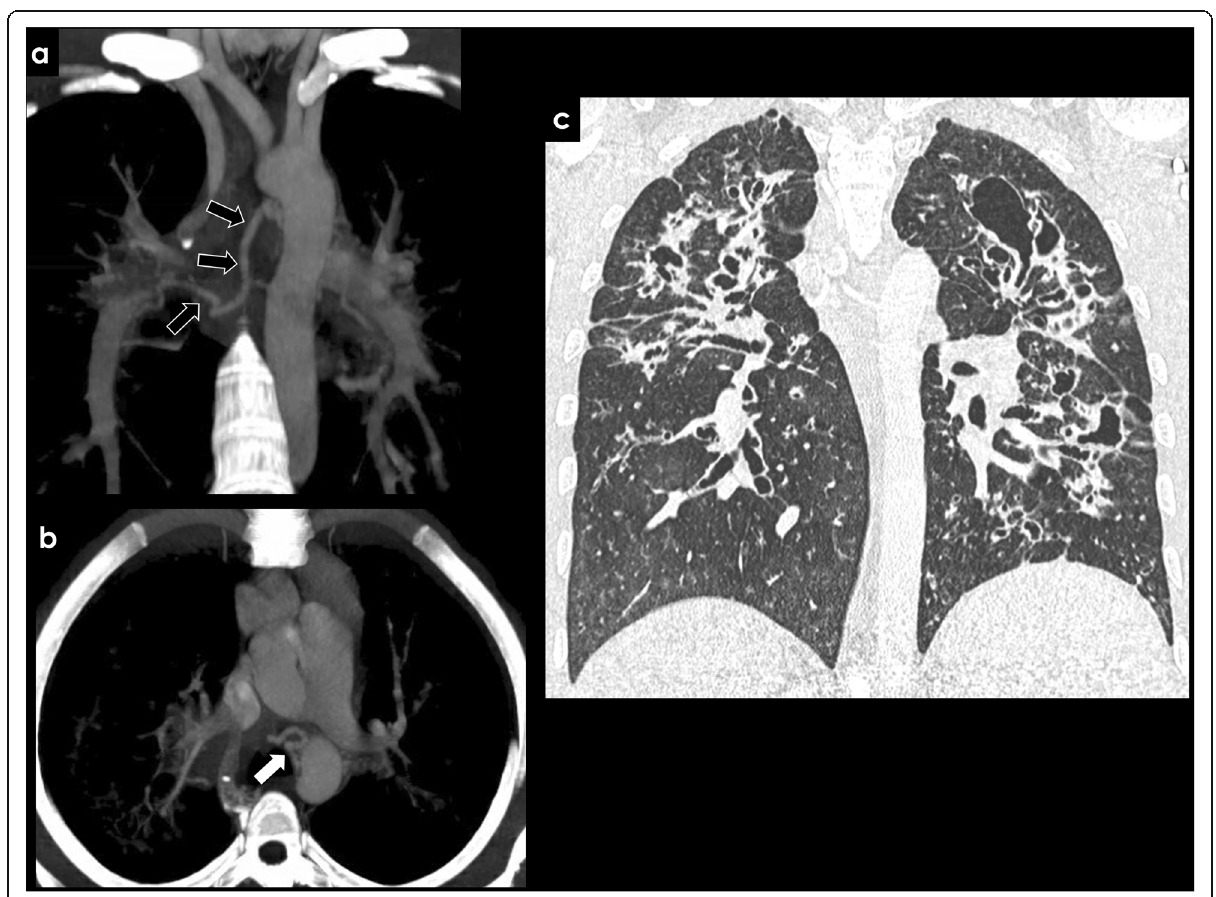
Fig. 7 Acquired causes of BAH — cystic fibrosis. Ectopic dilated bronchial artery arising from the distal portion of the aortic arch ( a , b ; arrows) in a